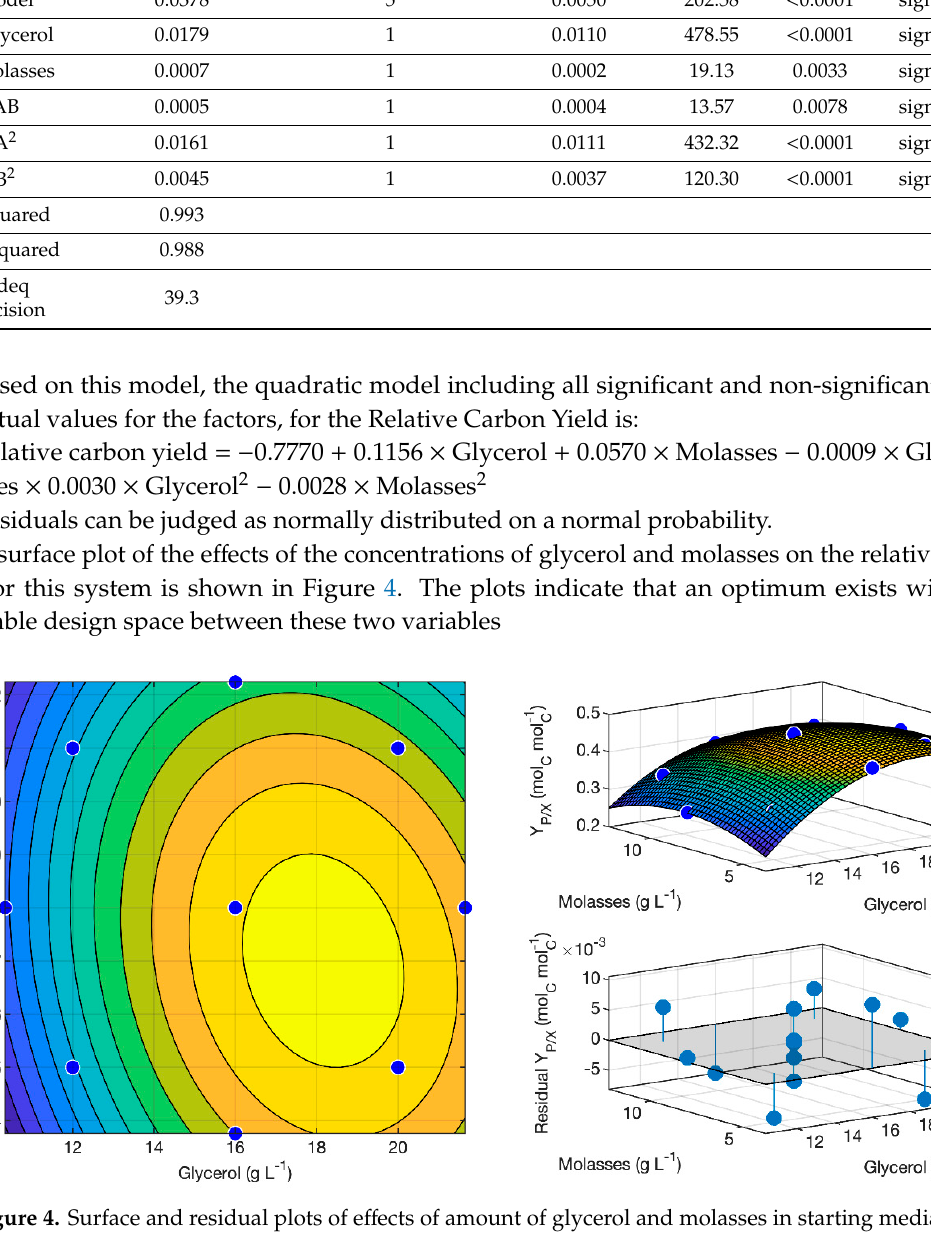
Figure 5. Fermentation products at the optimum glycerol:molasses ratio. Butyric acid is produced from the sugars present, then subsequently re-assimilated to increase the productivity of butanol. Conditions were tested in triplicate with the mean of the results presented. Error bars represent standard deviation from the mean.